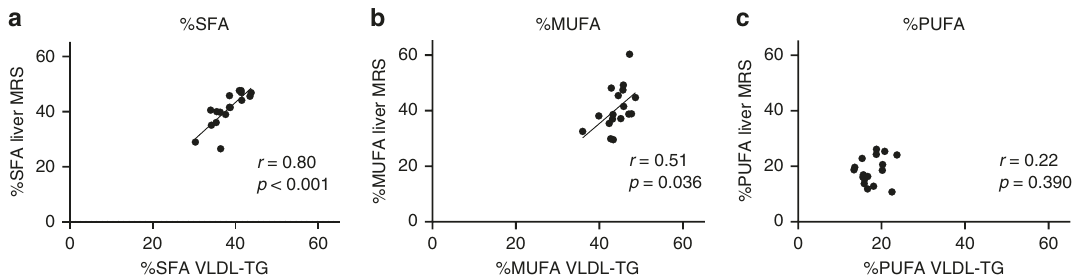
Fig. 4 The relationship between hepatic lipid composition and plasma VLDL-TG composition. Relationships are shown for the different lipid fractions: a SFA, b MUFA, and c PUFA ( n = 17). Hepatic %SFA determined with MRS and %SFA in VLDL-TG correlated signi fi cantly ( p = 1.38 × 10 − 4 ). The correlation coef fi cient is shown in the respective plots (two-sided Pearson correlation).